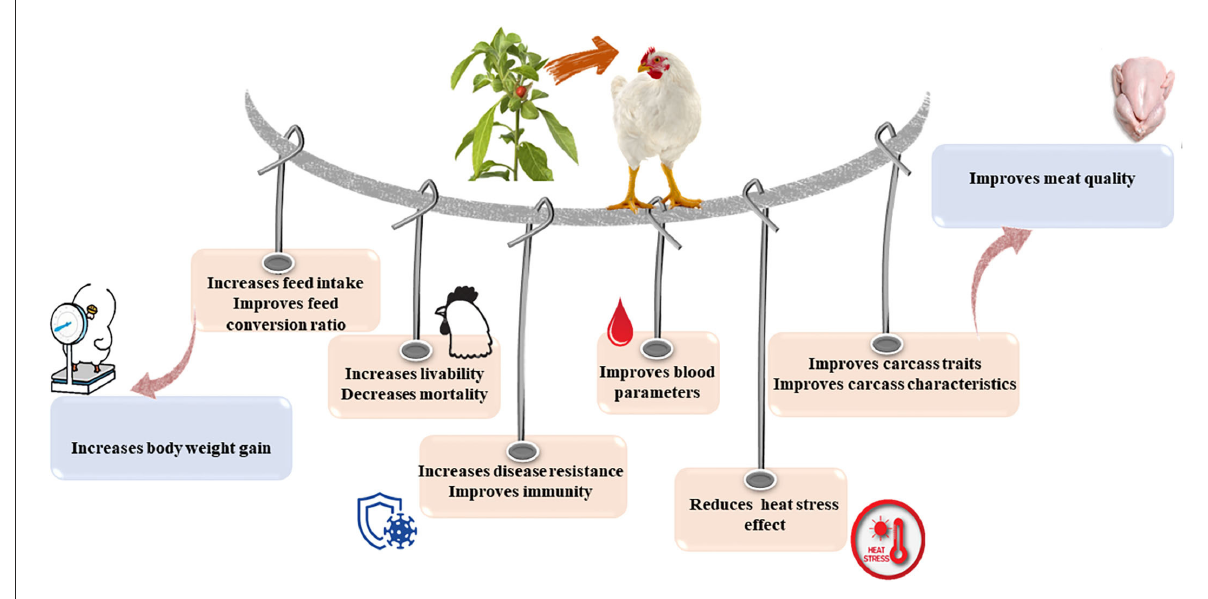
FIGURE3 Impacts of Withania somnifera supplementation on birds’ performance and